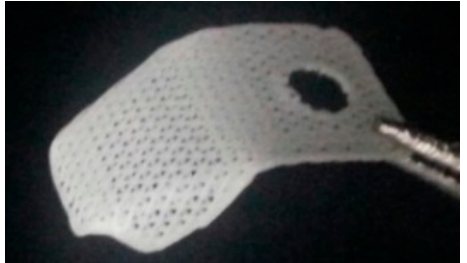
Figure 5. A PCL/PLGA/ β -TCP membrane produced using 3D printing technology. Pores were triangularly structured and completely interconnected.